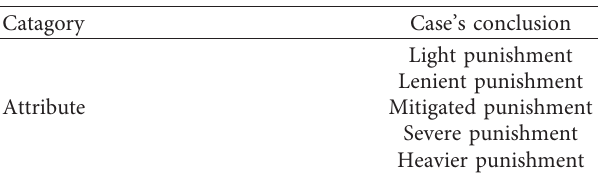
Figure 3: Continuous data encoder and discrete data Table 4: Case’s conclusion.